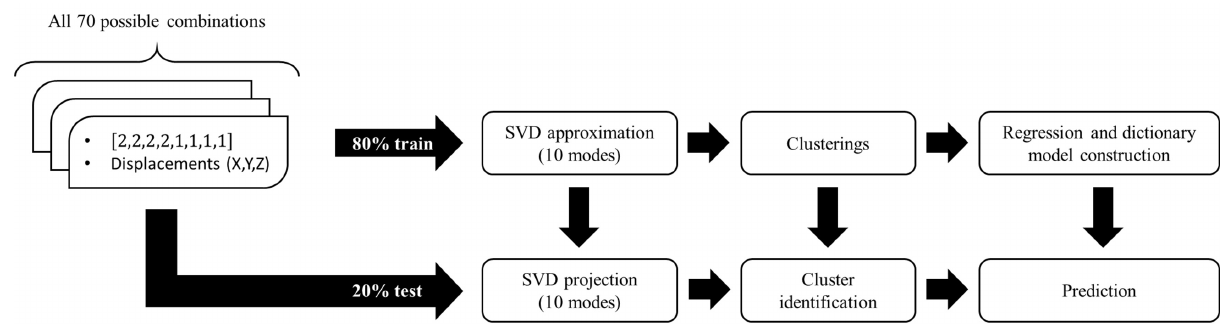
Figure 12. ROM generation